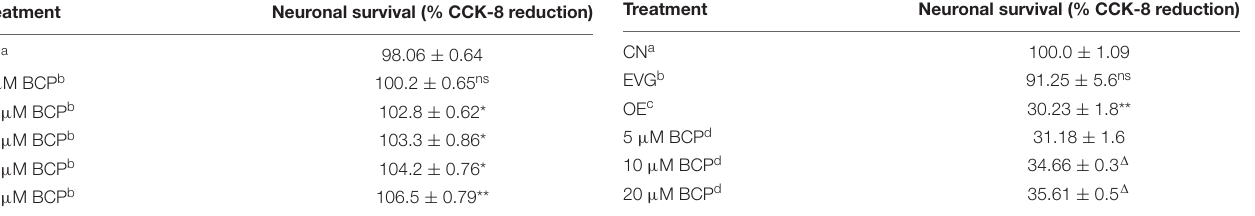
TABLE 2 | Effects of different concentrations of BCP on the 24-h viability of PC-12 cells. Treatment